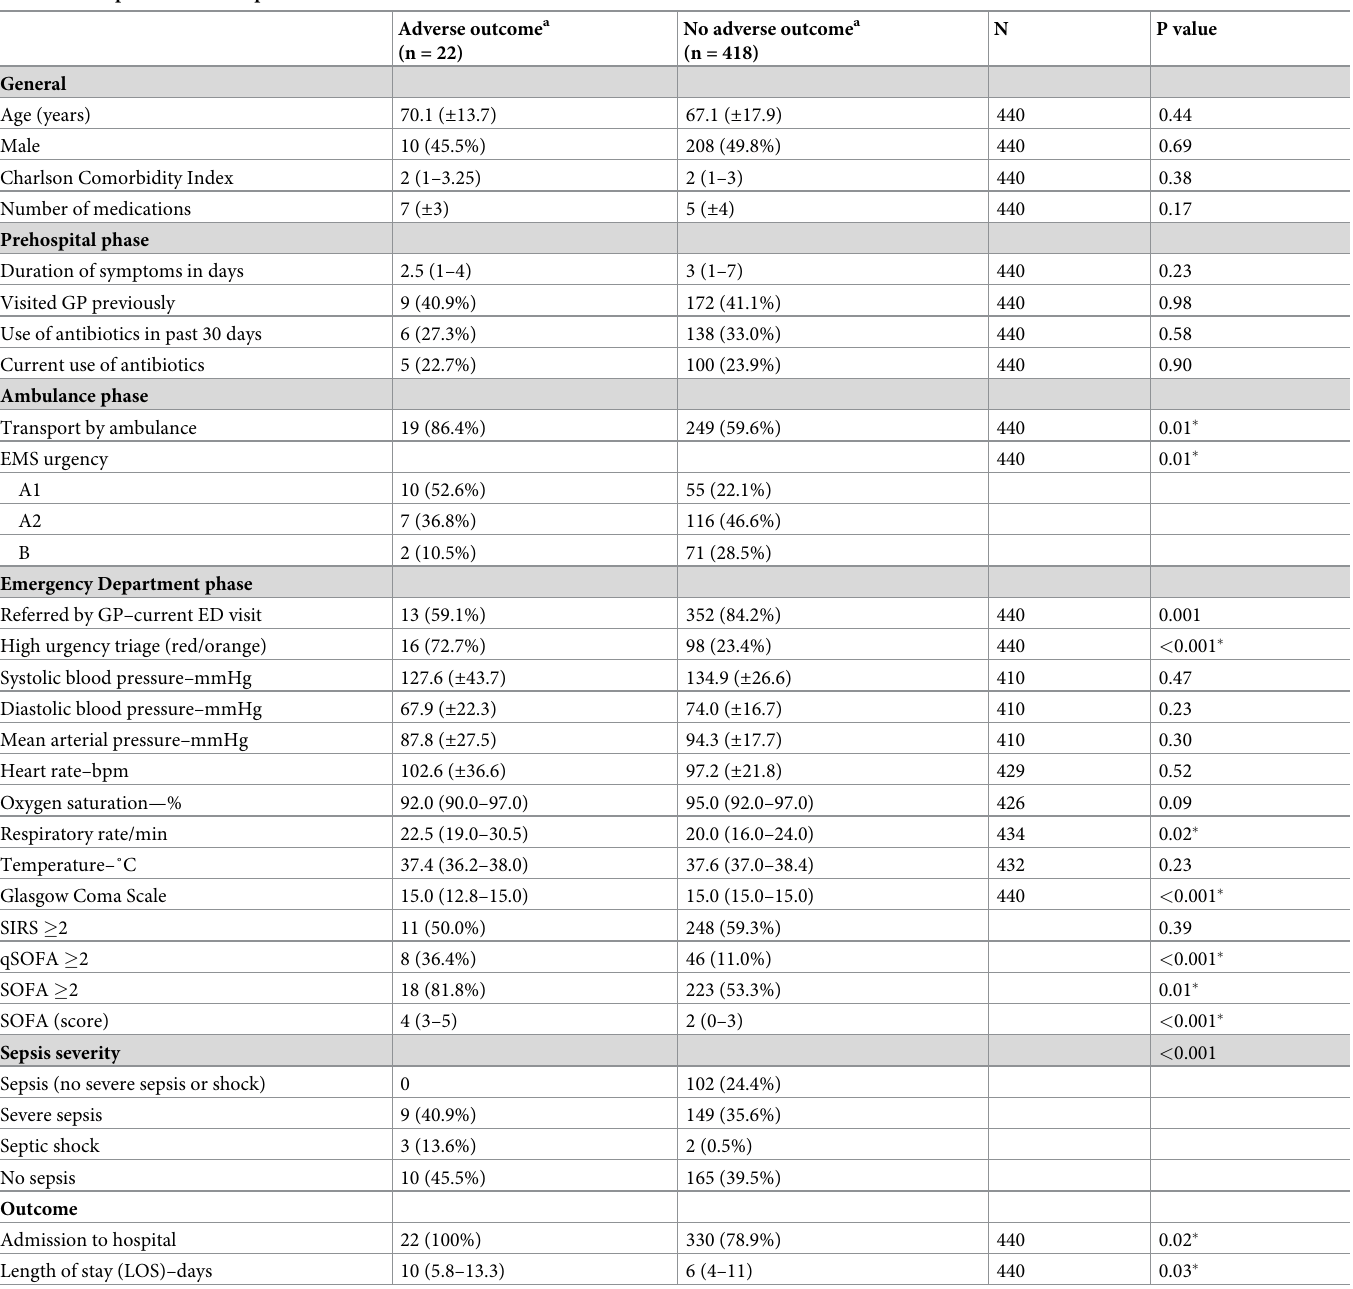
Table 3. Comparison between patients with and without an adverse outcome.